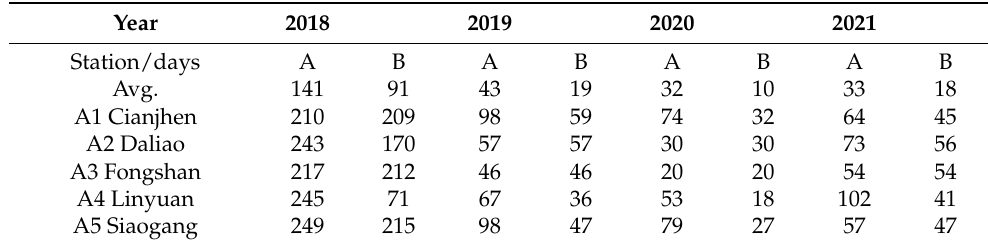
Figure 1. Industrial parks in southern Kaohsiung. Note: Ovals are industrial parks, rectangle names are administrative regions Source: Industrial land use and supply service, Industrial Development Bureau, MOEA, Taiwan, R.O.C. https://idbpark.moeaidb.gov.tw/ accessed on 9 March 2022. Table 1. AQI of focus areas in the years between 2018–2021. Source: Data are drawn from the statistics of the Environment protection administration, Executive Yuan, Taiwan, R.O.C. AQI, air quality index; Avg., National average; A, Days, AQI > 100; B, Days, PM2.5 >